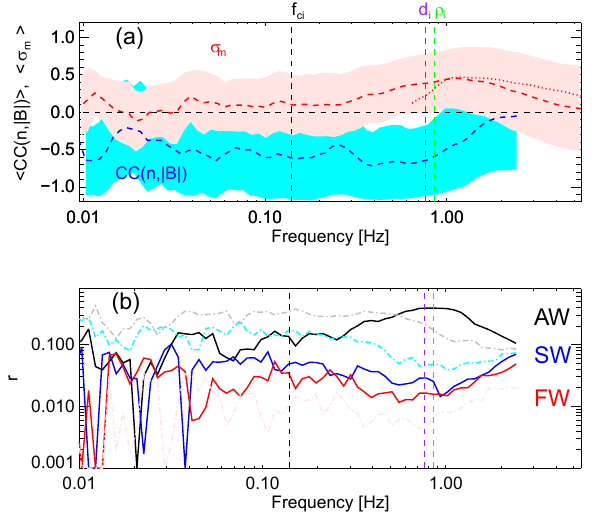
Figure 3. (a) Mean values at each spacecraft frame frequency for the helicity (red) and the wavelet cross-correlation (blue). Light shaded areas denote 1 standard deviation, and the dashed red line denotes the helicity from the search coil magnetometer. (b) Ratio of data points meeting the thresholds to the total number of points in the interval, which are defined in Table 1. The solid lines denote the ratio of points that meet the kinetic thresholds. Lighter dotted lines denote the ratio for the fluid